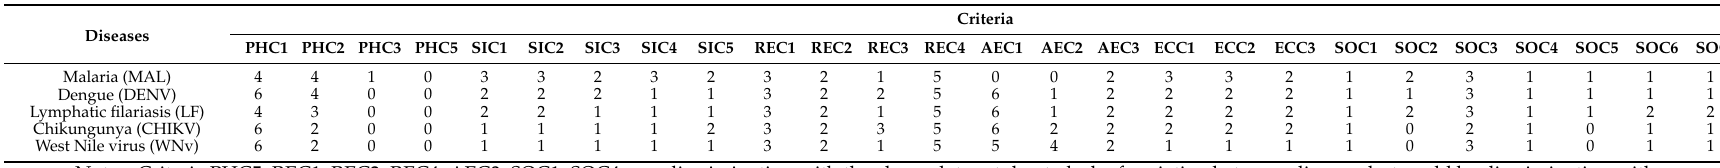
Table 2. Pilot climate sensitive infectious disease criteria evaluations for Burkina Faso (disease evaluation matrix showing evaluation scores for each of the five pilot diseases based on context specific data reviewed pertaining to each disease over all criteria).